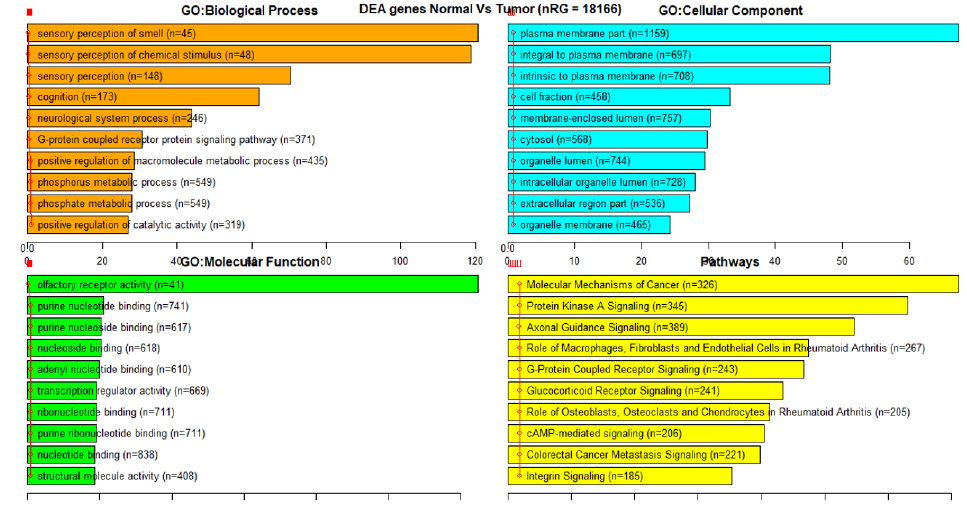
Figure A1. Gene Set Enrichment Analysis on all markers of